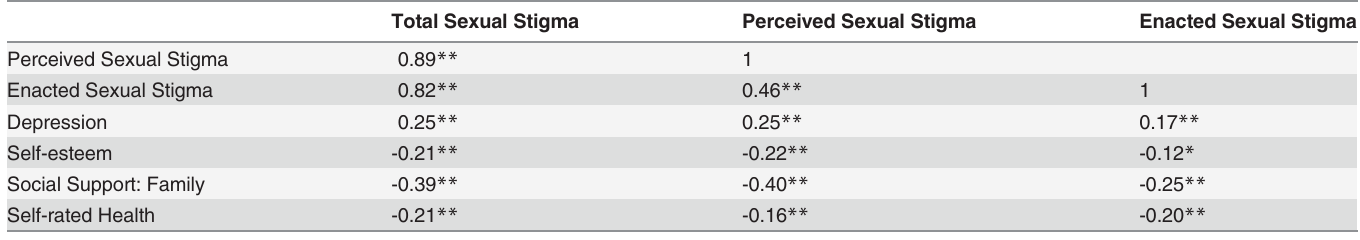
Table 3. Bivariate correlations between sexual stigma scale items, social support and health outcomes (phase 2 sample: n = 466). Total Sexual Stigma Perceived Sexual